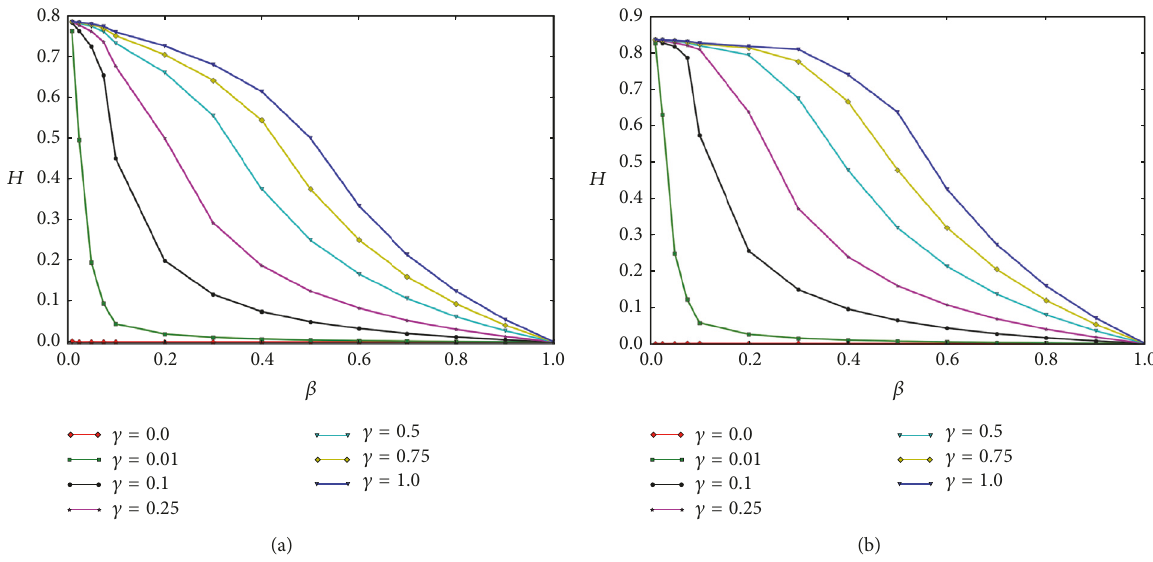
Figure 7: Hamiltonian computed using the 𝑋𝑌 model. (a) Results reached considering 360 different spin values. (b) Those reached using 4 spin values. The legend indicates the related value of 𝛾 for each curve. Results have been averaged over different simulation